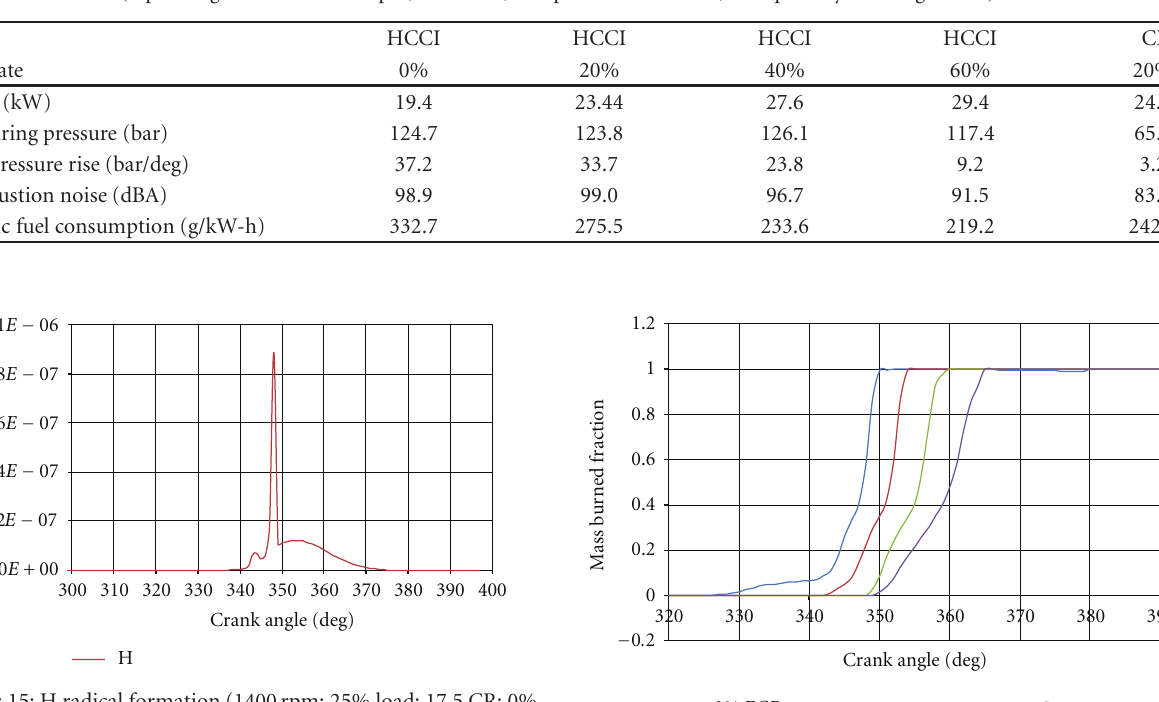
Figure 15: H radical formation (1400rpm; 25% load; 17.5 CR; 0% EGR).